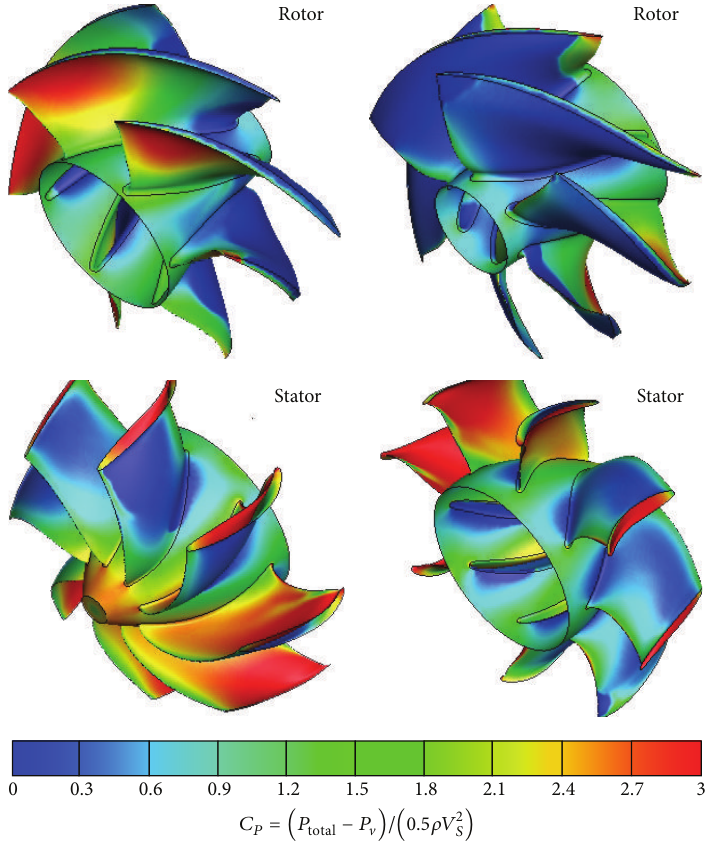
Figure 19: Pressure coefficient contours on the rotor and stator blades and